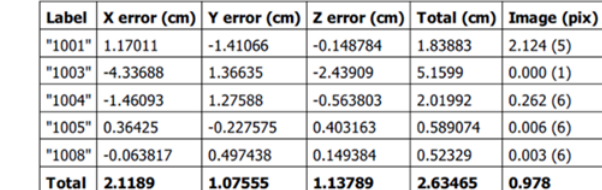
Figure 5. Dense point cloud of Castelsantangelo sul Nera